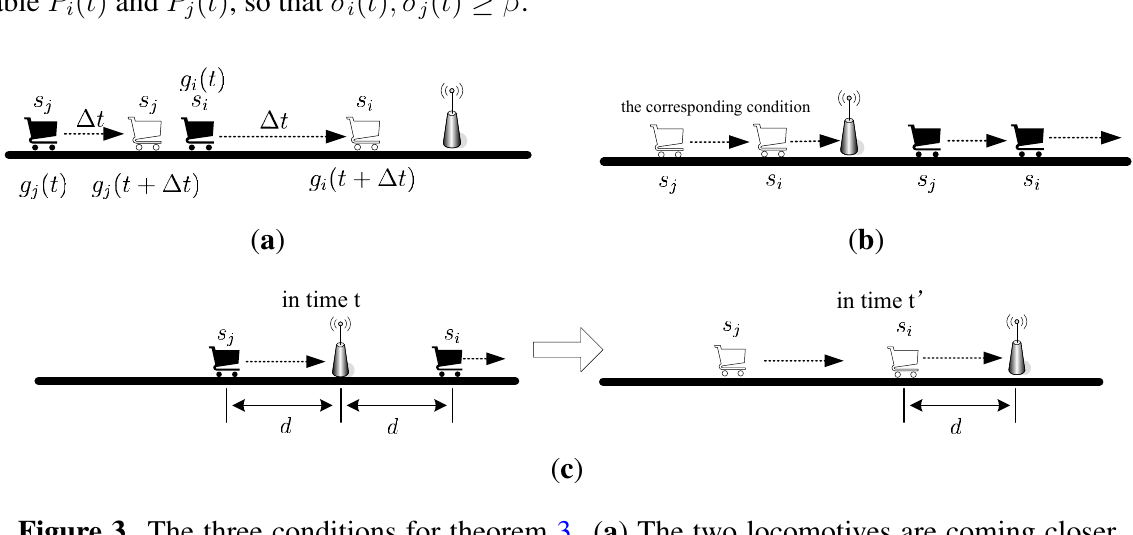
Figure 3. The three conditions for theorem 3. ( a ) The two locomotives are coming closer to the AP; ( b ) The two locomotives are moving away from the AP; ( c ) One locomotive is coming closer to the AP while the other is